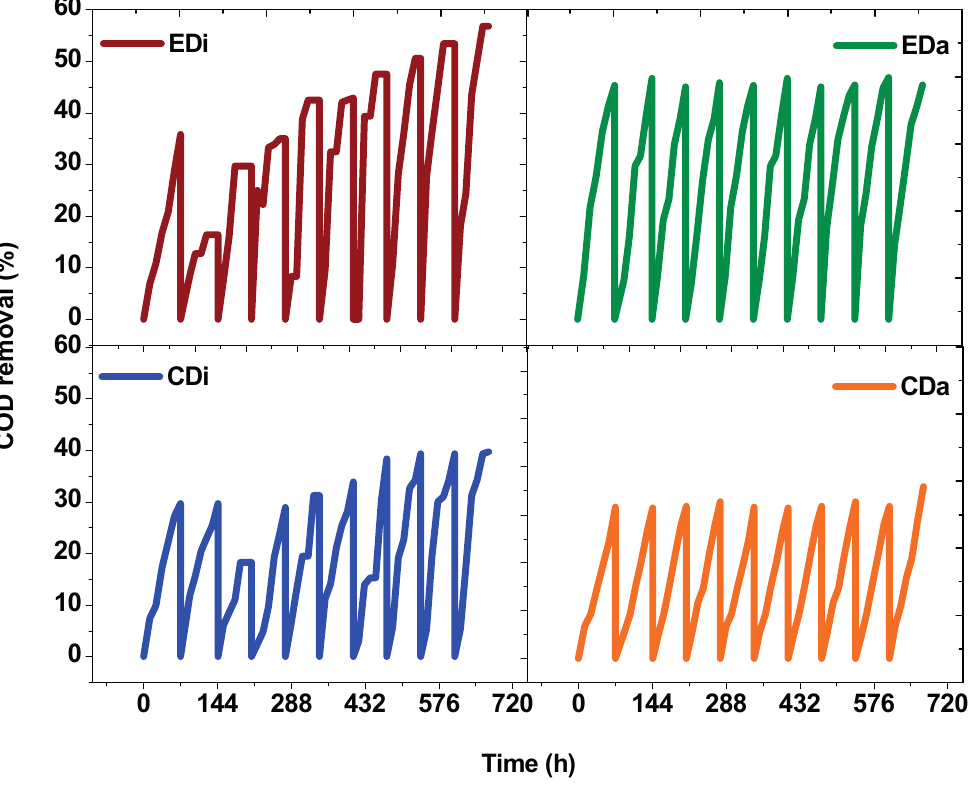
Figure 7. Substrate utilization in terms of chemical oxygen demand (COD) removal as function of time with distillery and dairy wastewater in dark-fermentative system (DFS-CDi, CDa) and augmented dark-photo fermentative system (ADPFS-EDi,